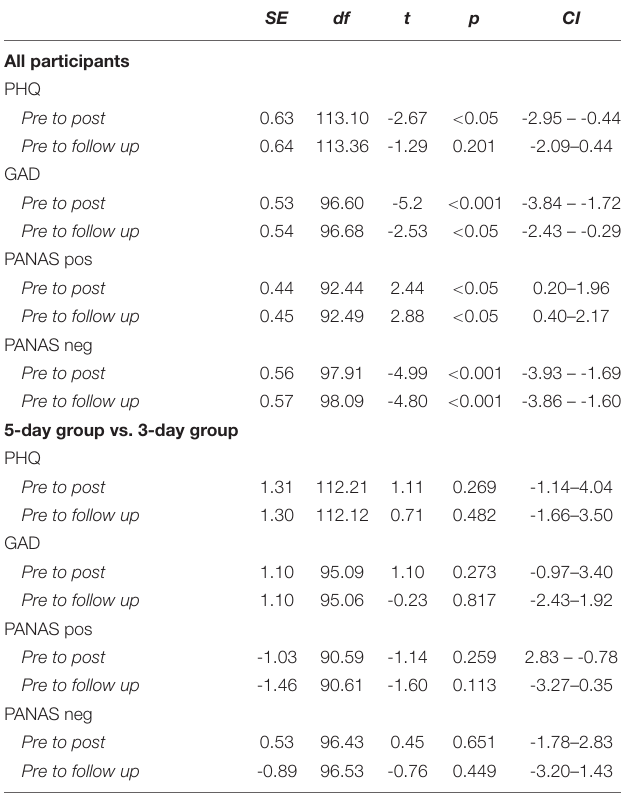
TABLE 7 | Intention to treat analyses from pre to post, and pre to follow